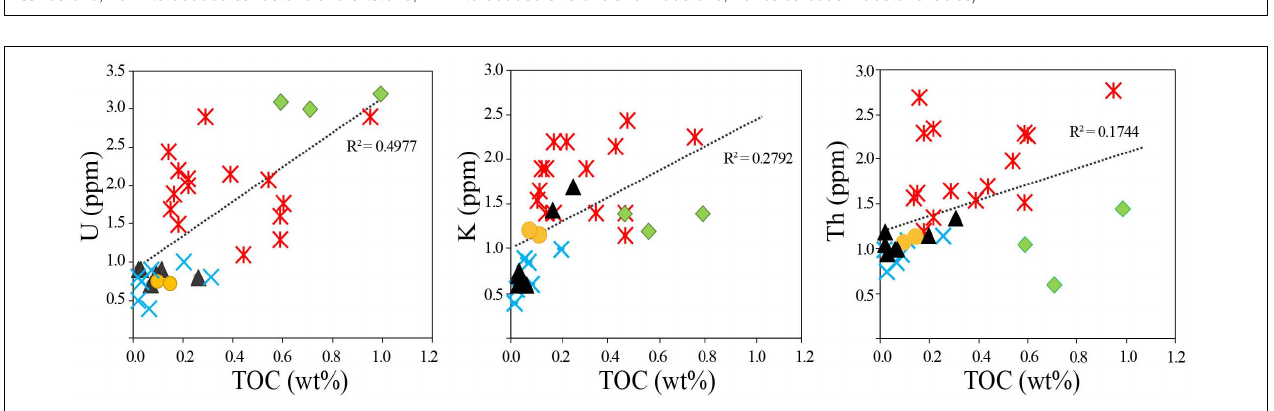
FIGURE 9 | Cross-plots of K, U and Th from outcrop spectral gamma-ray measurements of difference identified facies. (F1: Structureless sandstone, F2: Structured sandstone, F3: Interbedded sandstone and siltstone, F4: Interbedded siltstone and mudstone, F5: calcareous mudstone facies).